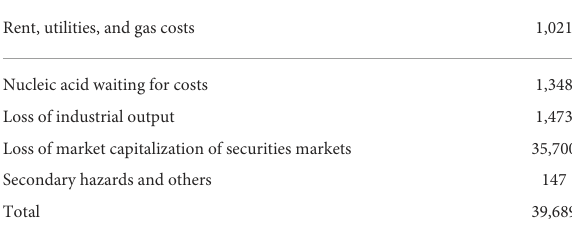
TABLE 5 Summary of hidden (Indirect) costs of shanghai sealing control (RMB